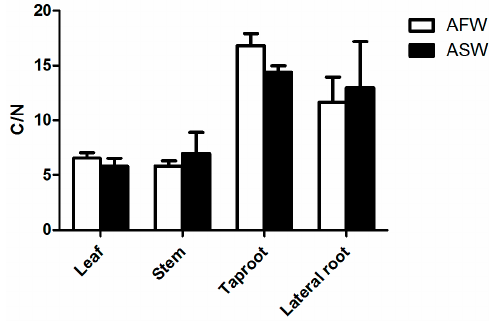
Figure 5. Carbon to nitrogen ratio (C/N) in leaf, stem taproot and lateral root of Beta vulgaris var. cicla cultivated in AFW and ASW. Bars indicate SD.